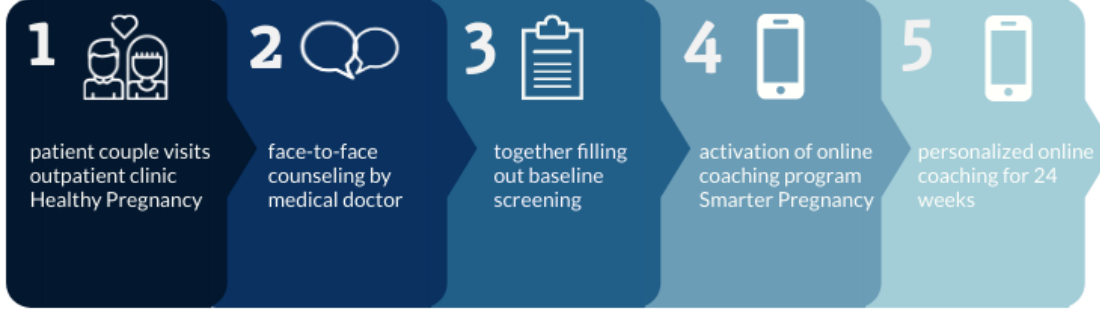
Figure 1. Diagram of the study